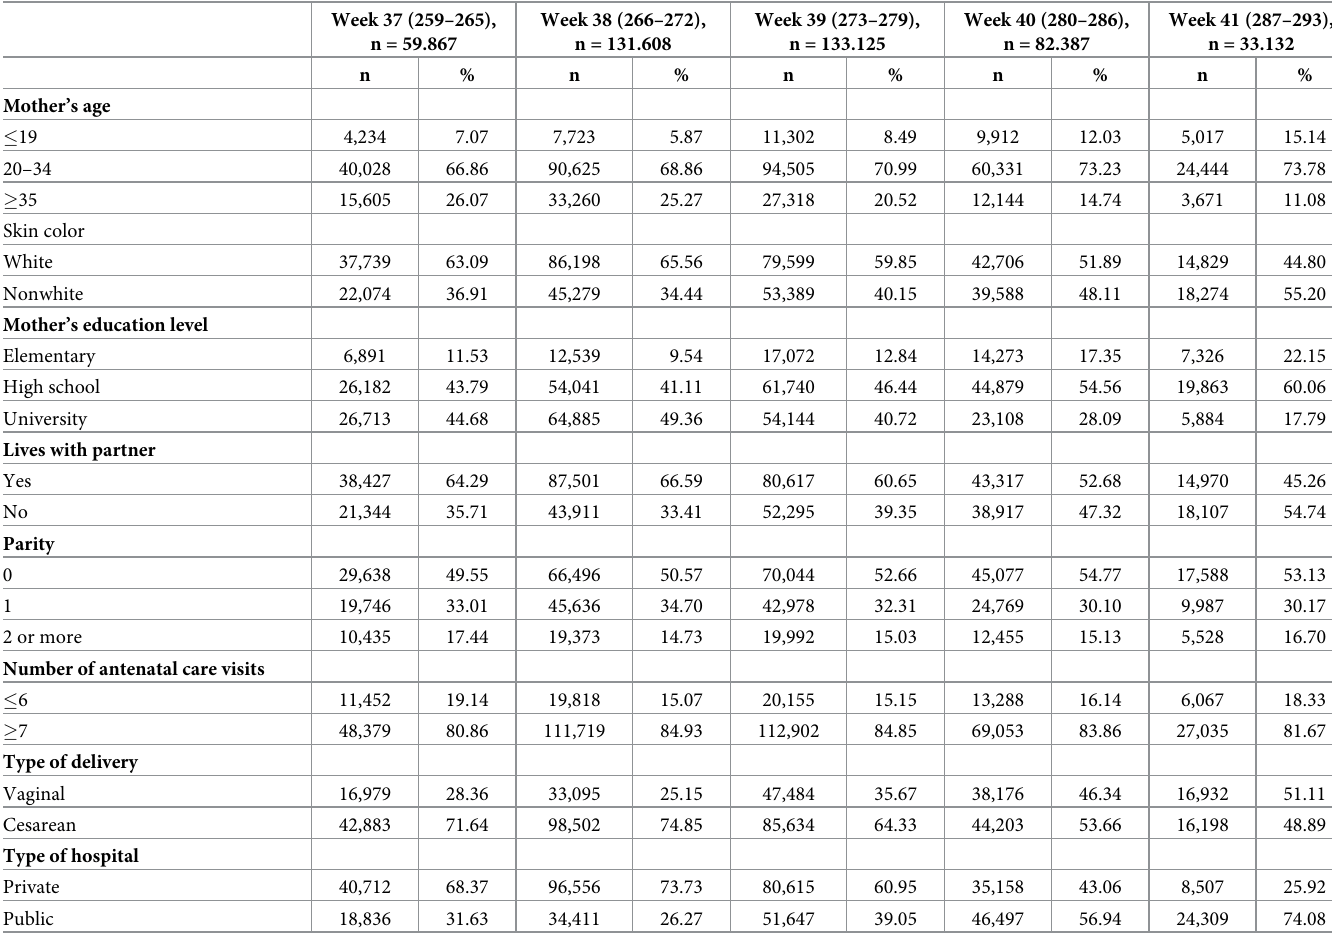
Table 1. Characteristics of the study population according to completed gestational weeks, municipality of S ã o Paulo, Brazil, 2012–2018 (n =